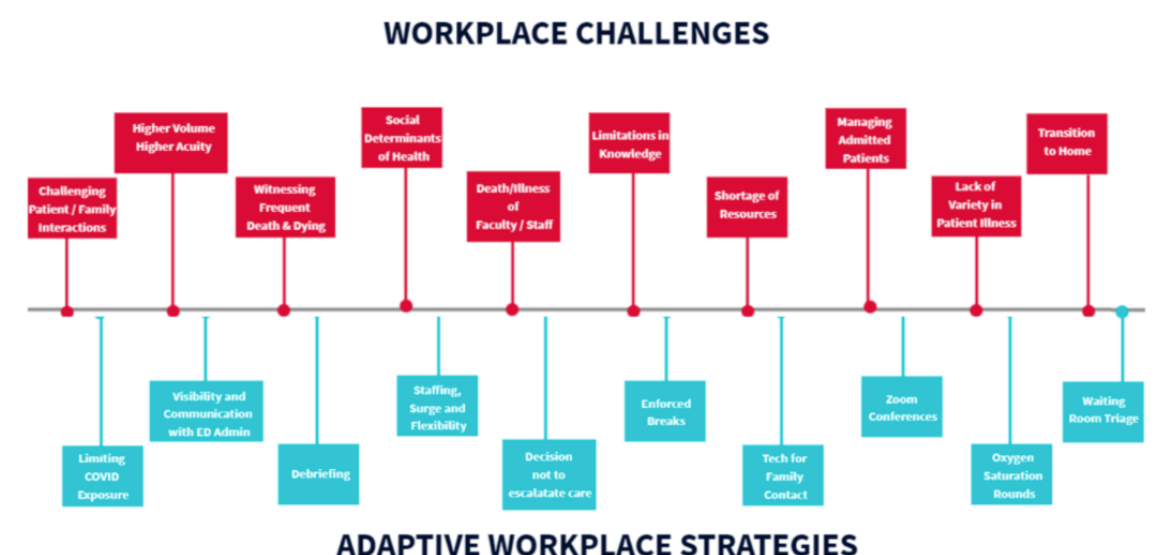
Figure 3. Diagram of a range of workplace challenges and adaptive workplace strategies experienced by 25 emergency medicine resident physicians when working and training during the first wave of the COVID-19 pandemic in two urban US hospitals, 2020. COVID-19, coronavirus disease 2019; US, United States.